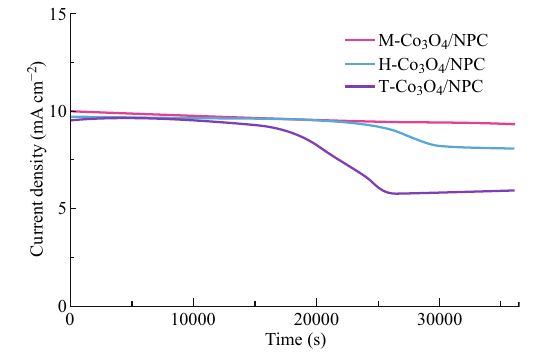
Fig. 10 Chronoamperometric responses of the M-Co 3 O 4 /NPC, H-Co 3 O 4 /NPC, and T-Co 3 O 4 /NPC composites at constant potentials of 1.53, 1.62, and 1.55 V, respectively Fig. 10, M-Co O /NPC displayed superior stability in 3 4 comparison with H-Co O /NPC and T-Co O /NPC, with 3 4 3 4 only a slight anodic current attenuation of 5.3% within 10 h. This result was attributed to the excellent structural stability of the flower-like carbon scaffold, which was also evident by the TGA results. Notably, the M-Co O /NPC 3 4 composite showed a better OER activity compared to not only most Co-based electrocatalysts, but also noble metal- based catalysts. A comprehensive comparison with previ- ously reported catalysts is given in Table 1.